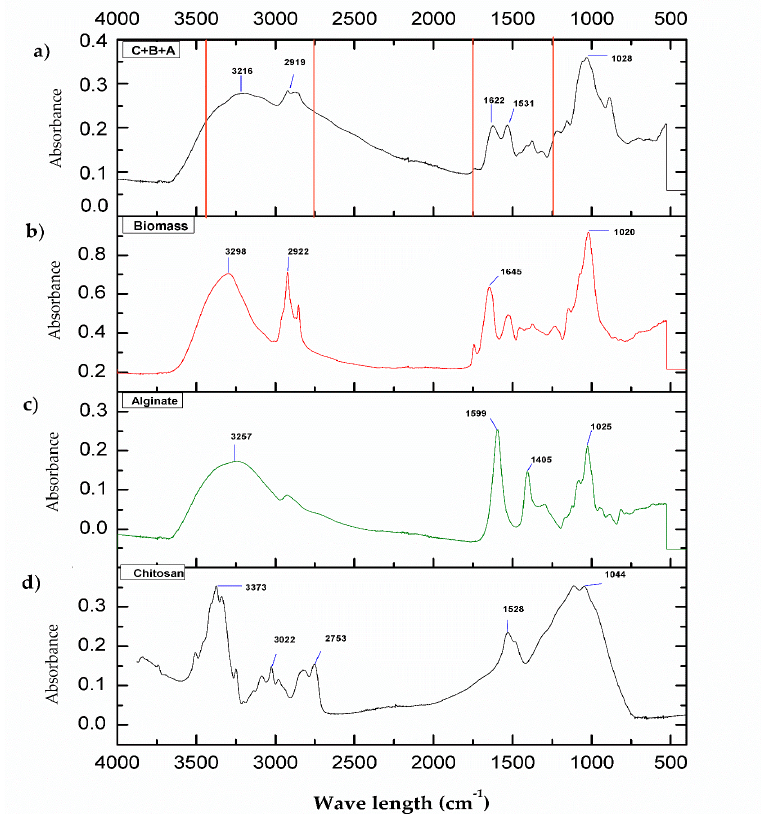
Figure 2. FT-IR of cross-linked chitosan composites with biomass and alginate as follows: a ) composite C+B+A; b ) fungal biomass; c ) sodium alginate, and d )